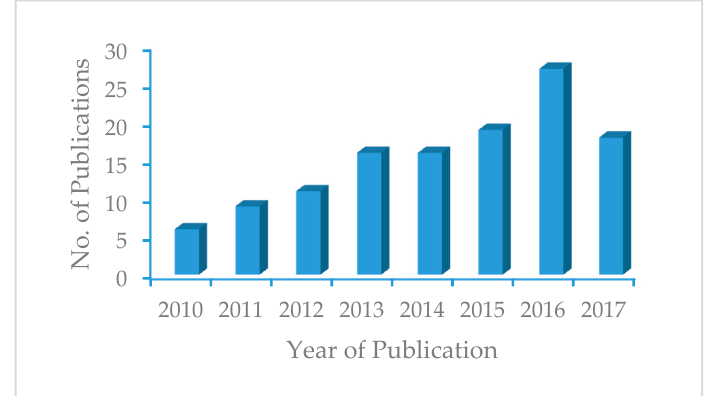
Figure 2. Distribution based on publication year.